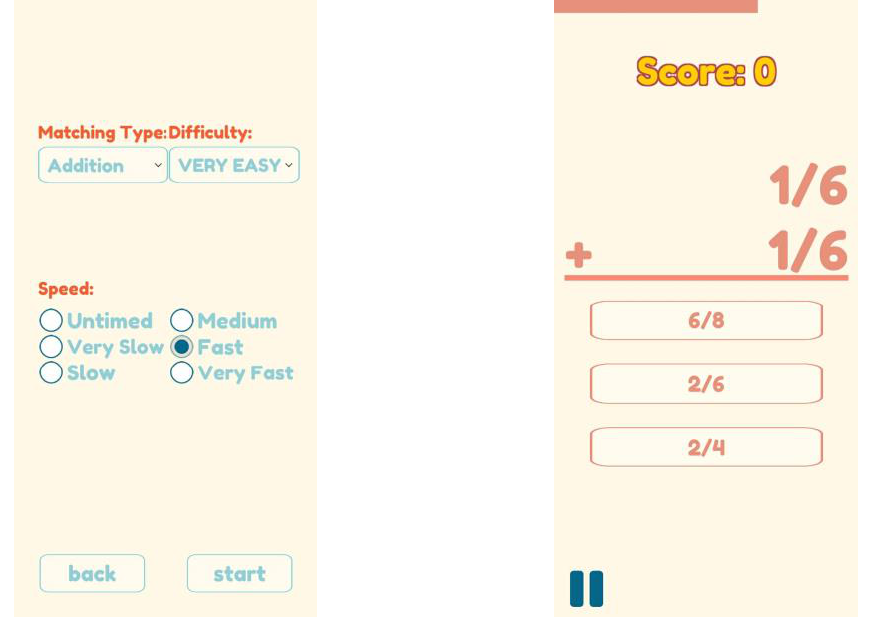
Figure 1. A sample game setting and actual arithmetic problem in Ibigkas! Math.